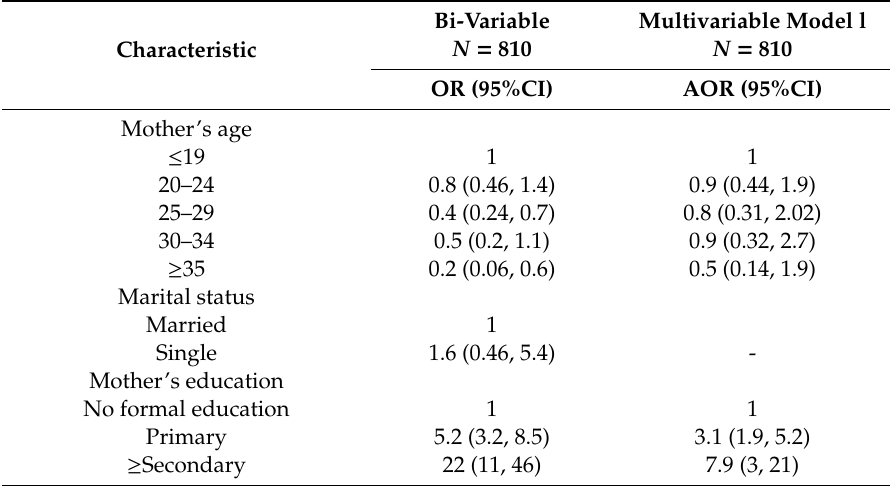
Table 2. Bivariate and multivariate logistic regression analysis of health facility birth in a community survey in Jubek State, South